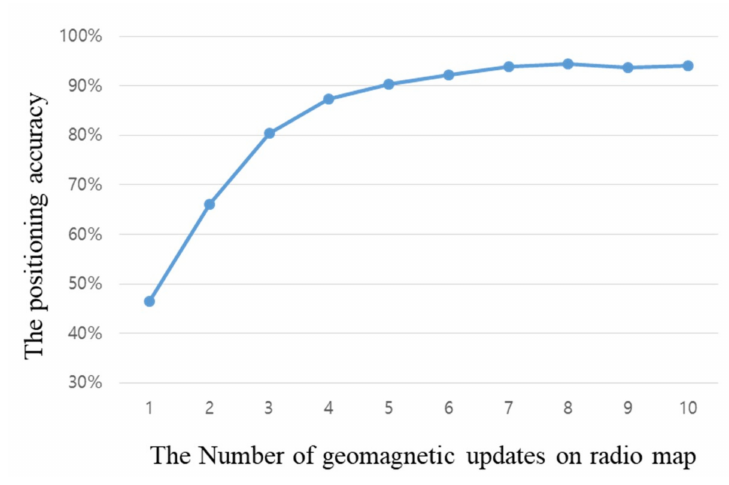
Figure 7. Positioning accuracy according to the number of geomagnetic sensor updates.